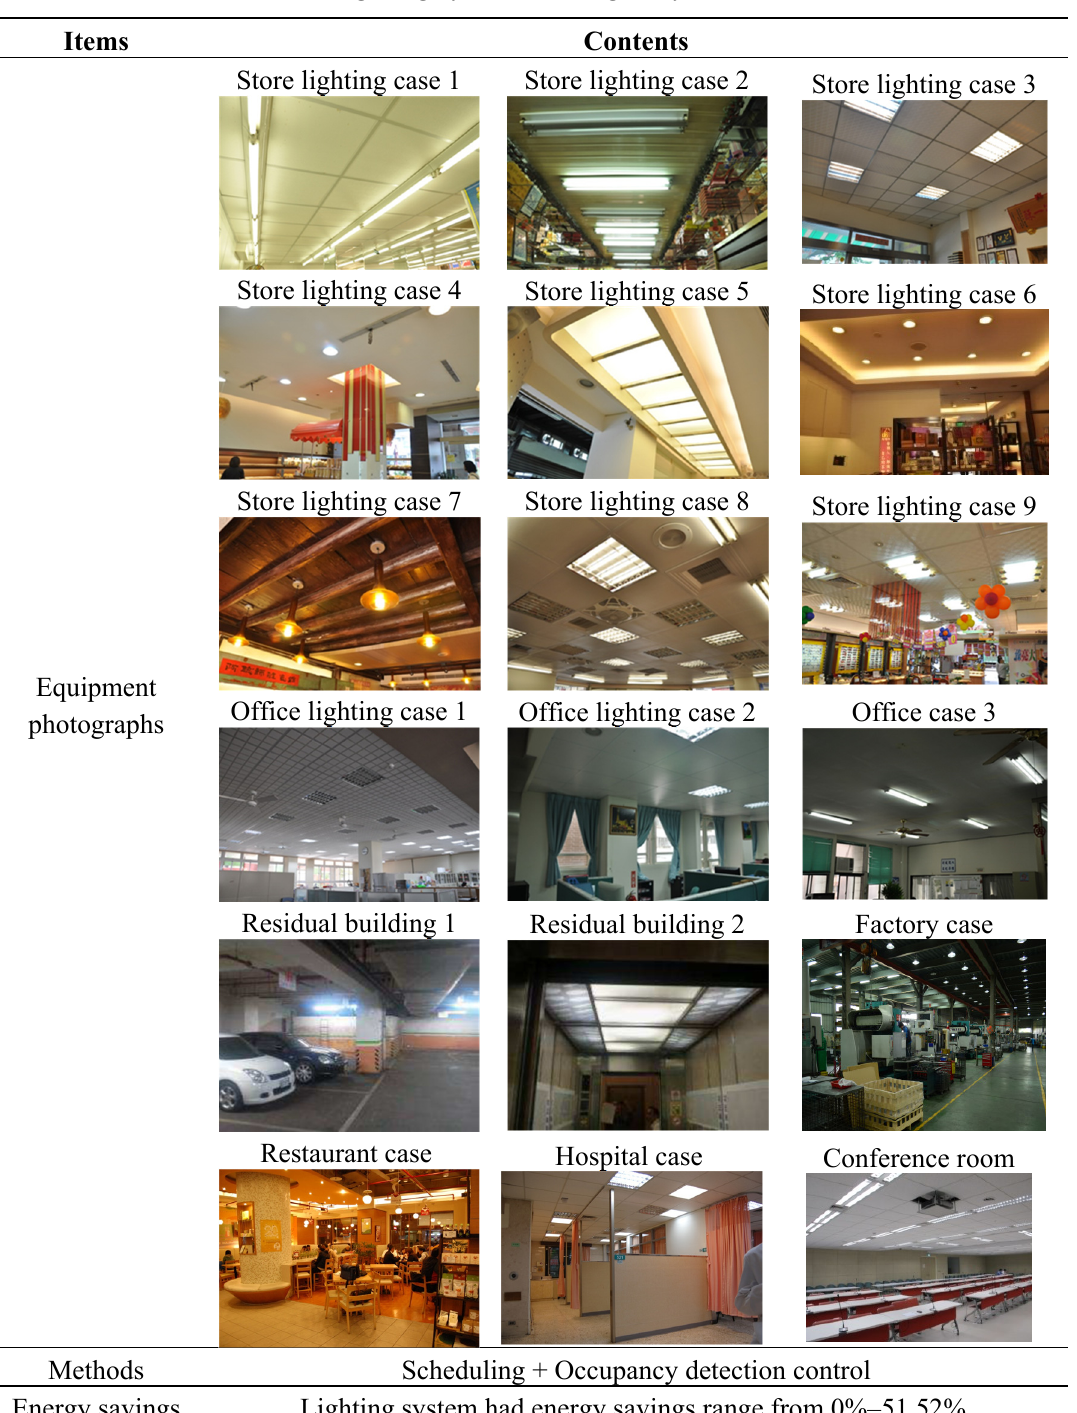
Table 8. Lighting systems managed by cloud